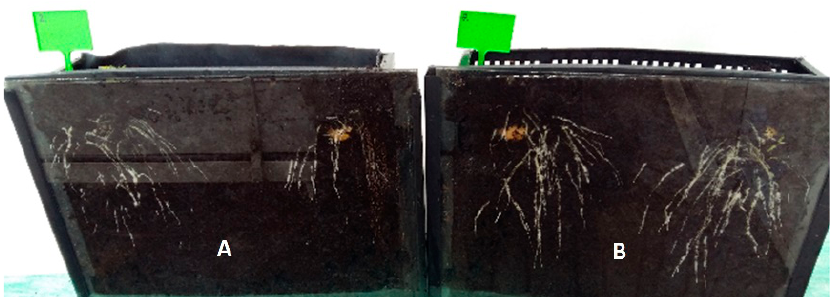
Figure 2. Soil profile overgrown by developing root system obtained from seed potatoes: ( A ) in- fected with phytopathogens; ( B ) biologically treated and then infected with phytopathogens.